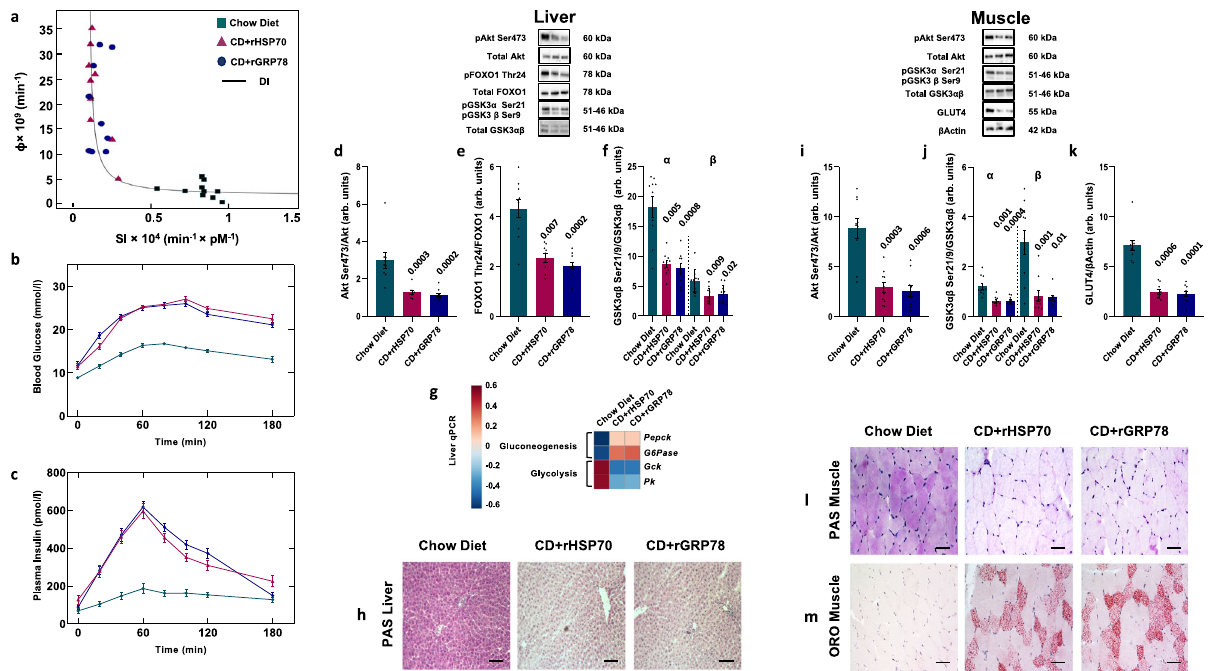
i – k Westernblotanalysisof AktSer473( i )and GSK3 αβ Ser21/9( j )phosphorylation and GLUT4 ( k ) expression in skeletal muscle. l , m Representative images showing PAS ( l ) and Oil red O (ORO) ( m ) staining of skeletal muscle sections from rats fed CDandinfusedwithrecombinantHSP70orGRP78orsalinesolution.Magni fi cation ×20. Scale bar: 0.10mm. Data are presented as mean value±SEM of n =10 biolo- gically independent animals. Statistical signi fi cances were calculated by Kruskal – Wallis test with Dunnett ’ s correction for multiple comparisons. Source data are provided as a Source Data fi